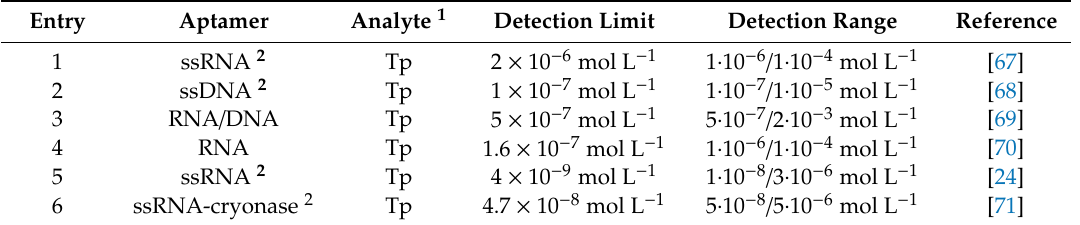
1 Ca ff eine: Cf; Theophylline: Tp. 2 ssRNA: single-stranded RNA; ssDNA: single-stranded DNA. 3 See text for